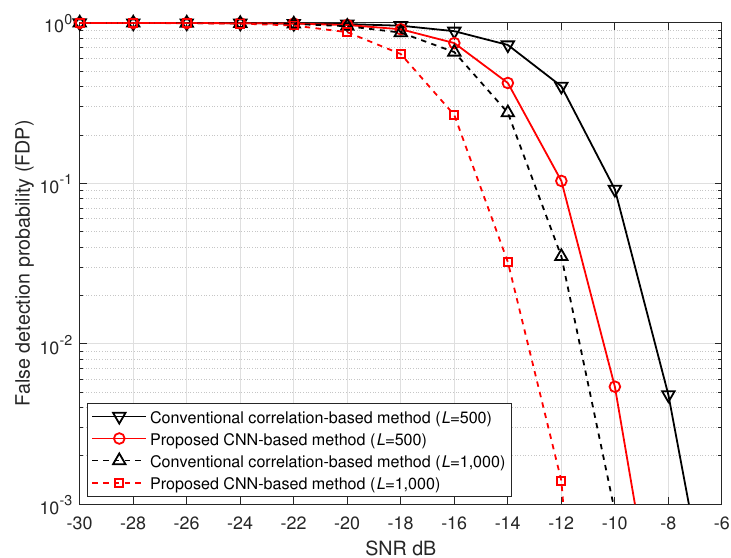
Figure 7. False detection probabilities (FDPs) of the proposed CNN-based and the conventional correlation-based synchronization methods in [6,8,10] for L = 500 and L = 1000.